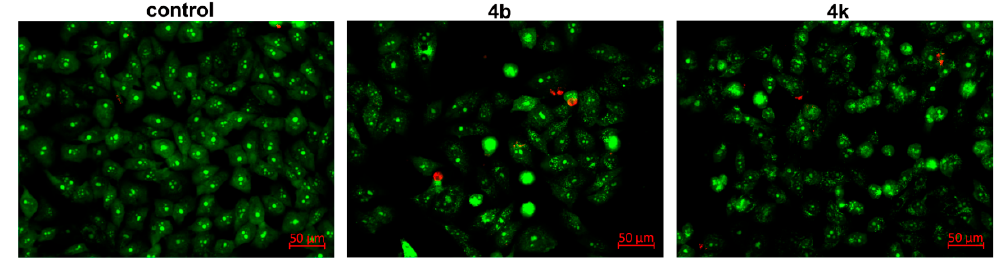
Figure 5. Photomicrographs of acridine orange/ethidium bromide-stained control HeLa cells and HeLa cells incubated with 2IC 50 concentrations of compounds 4b and 4k during 24 h (magnification 20x). Representative photomicrographs are shown.